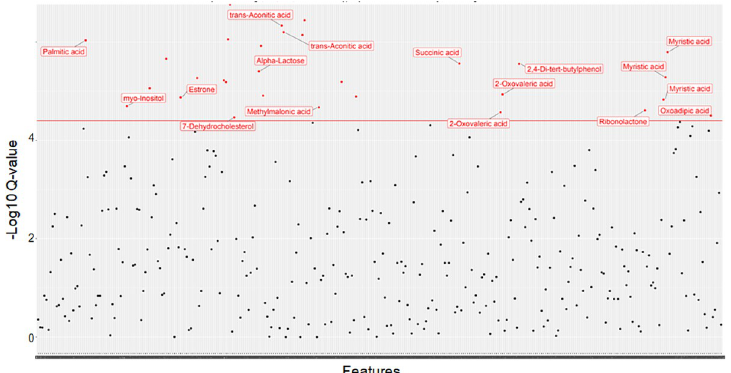
Fig 3. Association analysis of urine GC-MS spectral data in AVS patients and control individuals. Data were derived by GC-MS analysis of urine samples from 46 patients and 46 controls. Generalized linear models were used to determine significant associations between metabolomic peaks and AVS after adjusting for age, sex, body mass index, hyperlipidemia and diabetes, and correcting for multiple testing. Signal intensities normalized to the internal standard 2-isopropylmalic acid are plotted against the Q-values. Features showing evidence of statistically significant association with AVS (q values < 0.05) are shown with red dots.